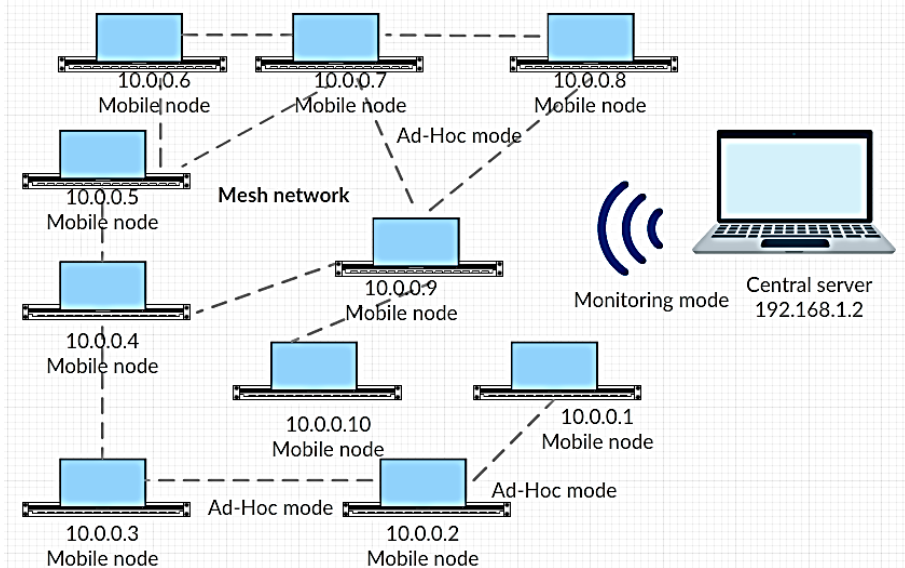
Figure 2. Model of wireless network for a group of mobile robots.